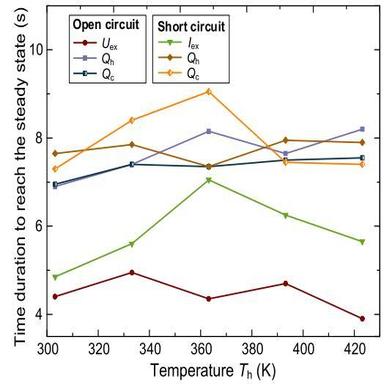
Determination of the unified time duration Δt for each stepped temperature rise.